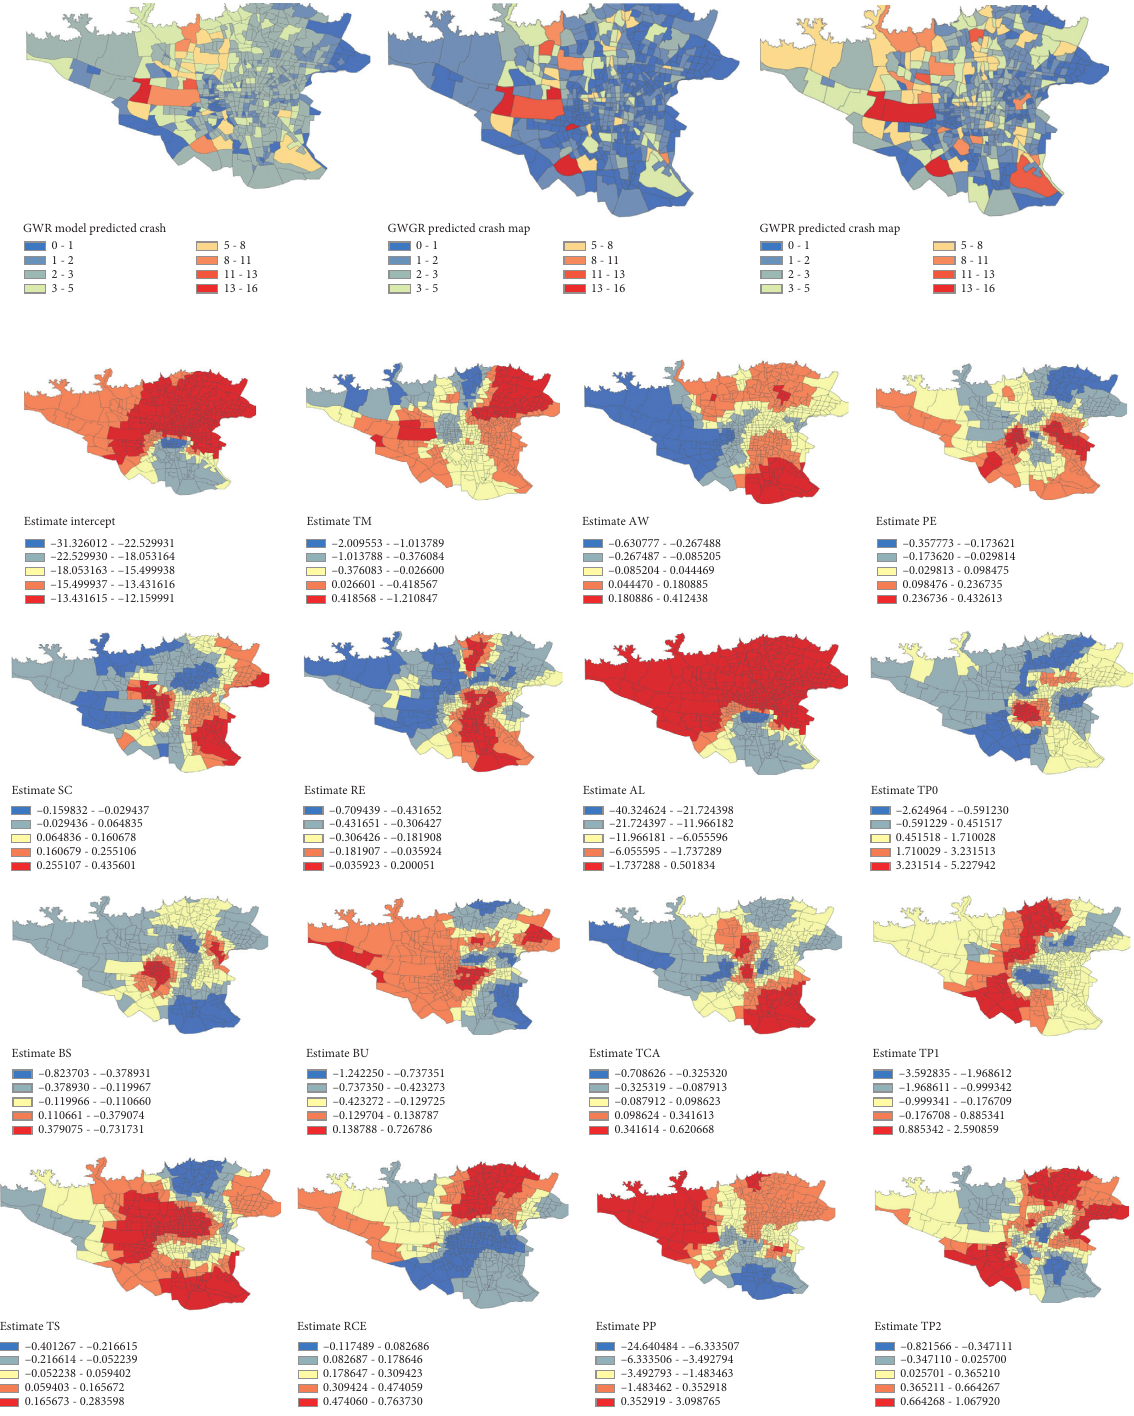
Figure 3: Crash predictive maps for GWR, GWGR, and GWPR